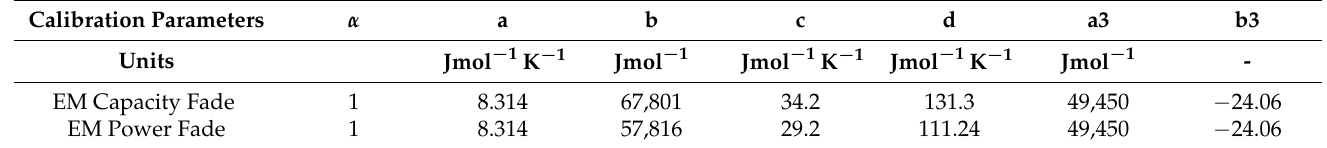
Table 1. Empirical model: calibrated capacity fade and power fade model